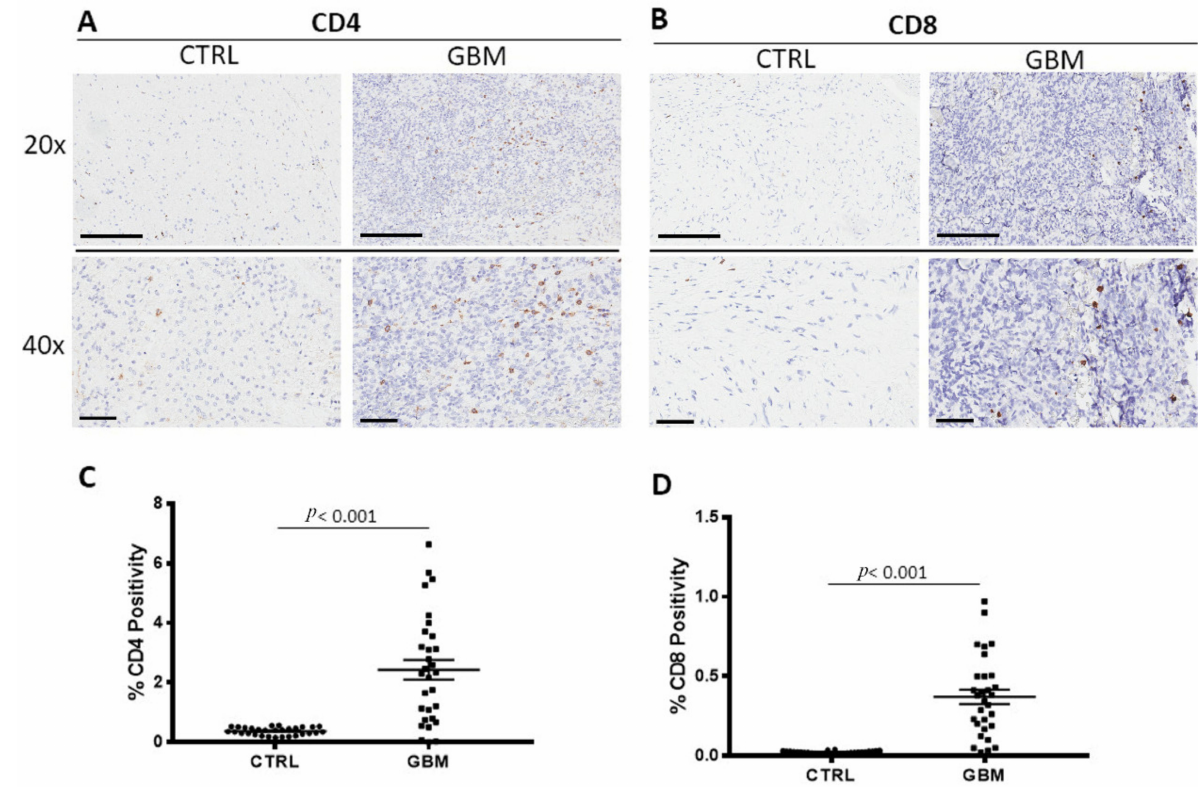
Figure 3. Immunohistochemical staining for T- helper lymphocytes CD4 + ( A ) and cytotoxic T- lymphocytes CD8 + ( B ) in both the center of tumor (GBM) and in the healthy surrounding areas (CTRL). Scale bar: 60 µ m (40 × ), 200 µ m (20 × ) ( A ). Morphometric analysis indicating the percentage of CD4 ( C ) and CD8 ( D ) positivity in GBM and CTRL